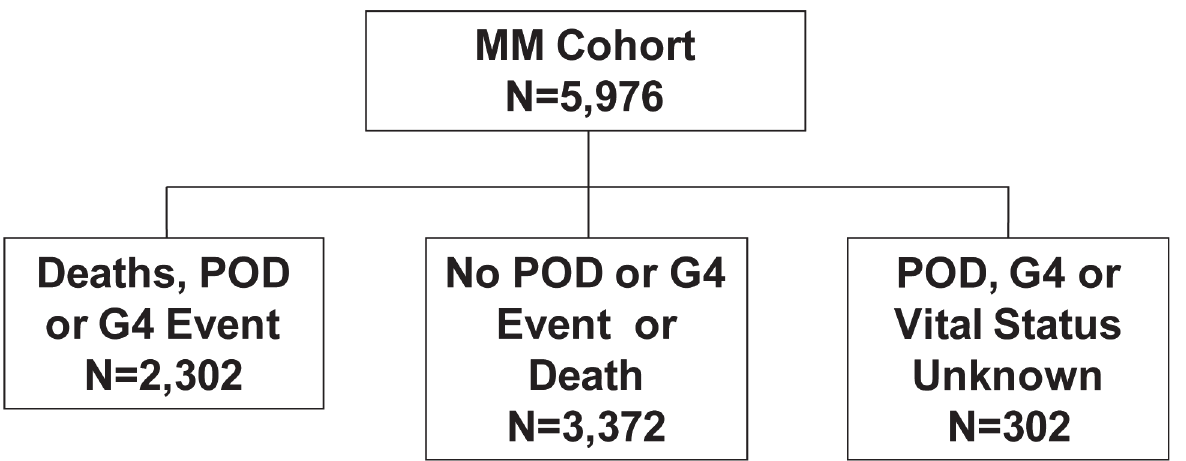
Fig 3. Event Status at the End of Follow-up for the Morbidity and Mortality Cohort.